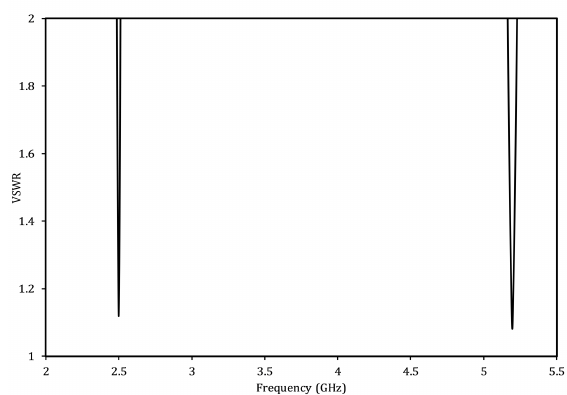
Figure 9. Reflection coefficient of conventional dual band antenna.